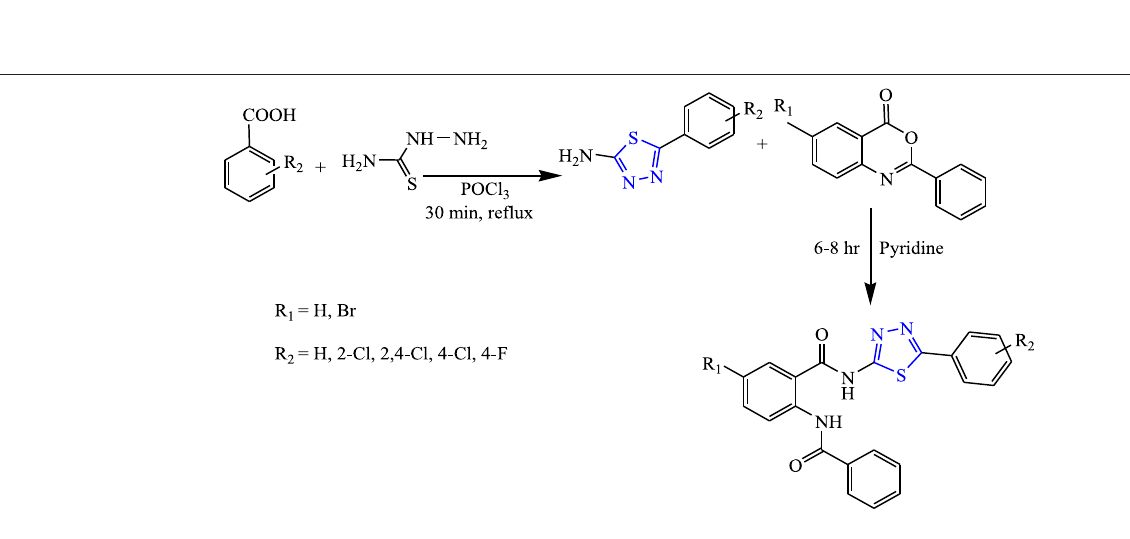
FIGURE 22 | Systematic scheme for synthesizing carboxamide 1,3,4-thiadiazole derivatives.